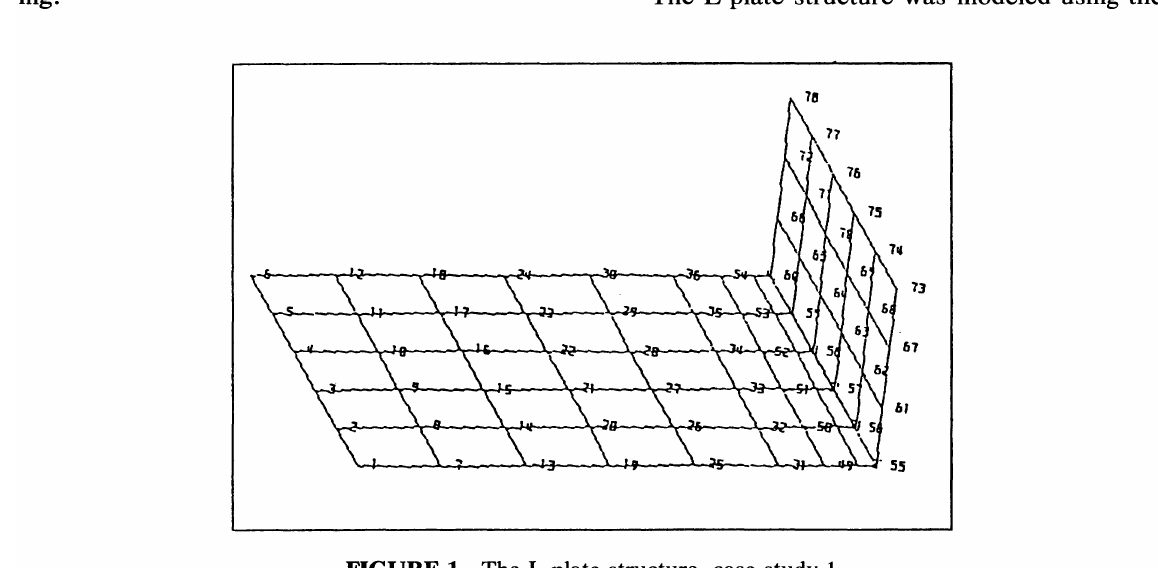
FIGURE 1 The L-plate structure, case study